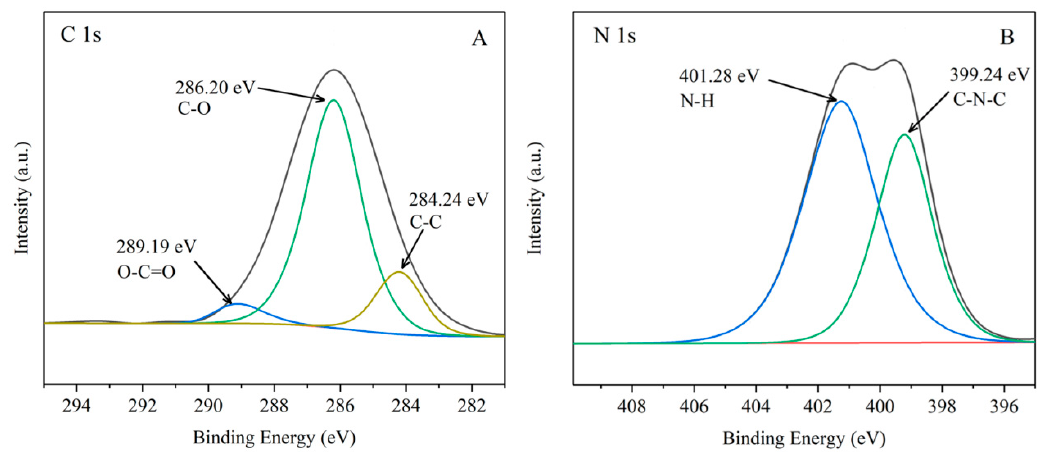
Figure 2. XPS spectra of G- β -CD: ( A ) C 1s and ( B ) N 1s.